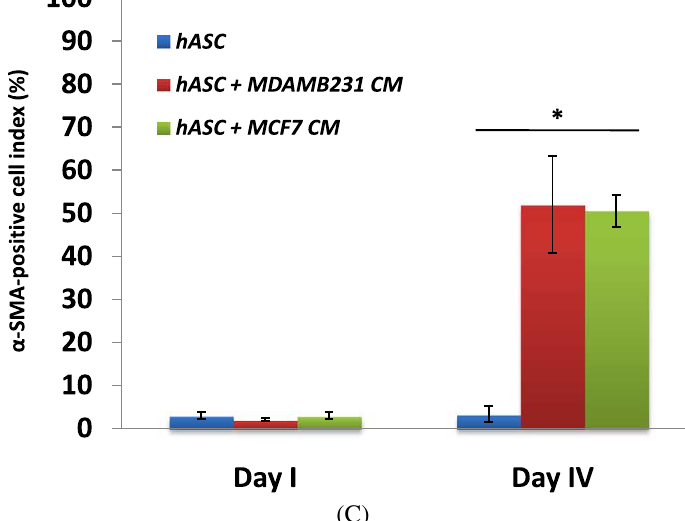
Fig. 2. Tissue resident mesenchymal stem cells express myofibroblast markers under the influence of tumor-derived factors. (A) Brightfield picture of direct co-culture of MDAMB231 cells or MCF7 cells with hASCs grown in serum-free medium over four days (a, b). The co-culture of hASCs with MDAMB231 (c) or MCF7 (d) and monocultures of either MDAMB231 (e), MCF7 (f) or hASCs (g) were grown four days in serum-free medium and the expression of α -SMA (green channel) was determined by immunostaining with an anti- α -SMA antibody. Nuclei were counterstained with Hoechst 33342 and appear blue. Scale bar: 100 µm. (B) hASCs were cultured in serum-free medium (a, d) or with serum-free tumor conditioned medium from either MDAMB231 (b, e) or MCF7 cancer cells (c, f) for 4 days and stained with anti- α -SMA (a–c) and anti-tenascin-C (d–f) antibodies, respectively. Scale bar: 100 µm. Representative pictures from at least three independent experiments are shown. (C) Quantitative analysis of the expression of α -SMA in hASCs cultured for one to four days in either MDAMB231 or MCF7